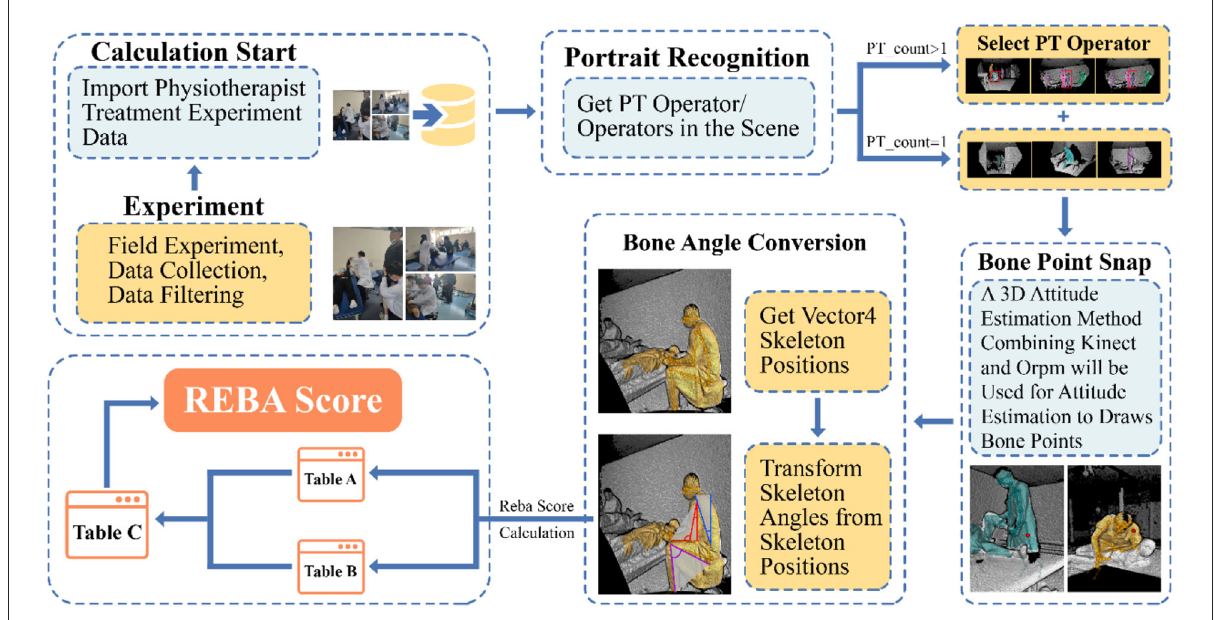
FIGURE3 Procedures of automatic ergonomics assessment tools. Once Kinect has scanned the spatial environment and the person, the researcher can select the person index to capture the motion of the specified person within the scene. Confirming the capture object, the automated algorithm will calculate the angle value based on the bone joints and bone length, which finally corresponds to the REBA score “+” (The REBA score is a combination of REBA Table A and REBA Table B). The generated data will be saved to the local port in real